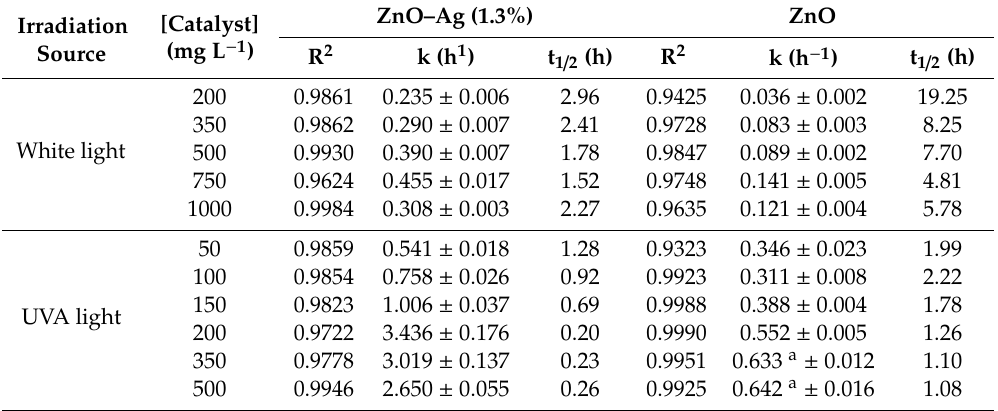
Table 1. Kinetic parameters for the photodegradation of OII with ZnO–Ag (1.3%) and ZnO